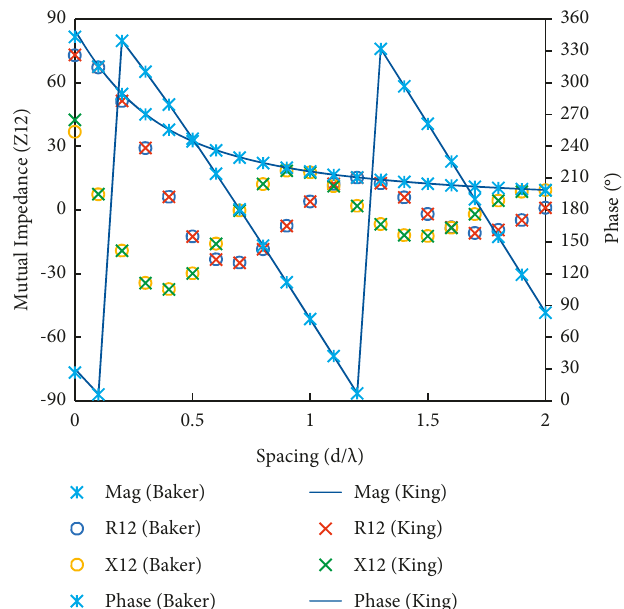
Figure 1: Mutual impedance between the two parallel dipole antennas with spacing d